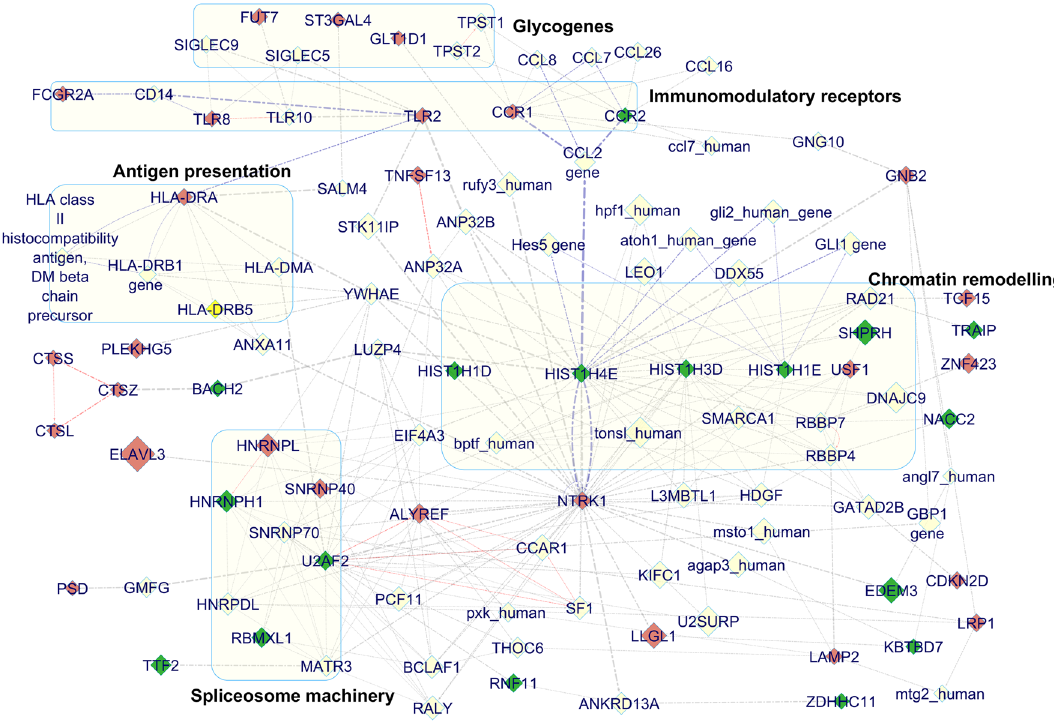
Figure 4. Integrated network model of 82 DEGs from the top ranking gene family clusters identified from the blood samples of anti-depressant drug treated MDD patients using the CPDB induced network modules. The compact network model is created by applying a z-score threshold of 20 in the CPDB user interface. GeneMANIA Force Directed Layout in the Cytoscape visualization tool was used for manually aligning and analyzing the exported network from CPDB. Colours of the nodes are adjusted based on gene expression data wherein wine red colour represents upregulated genes and dark green represents the downregulated genes. The core network modules with maximum DEG representation is highlighted in the graph using light yellow